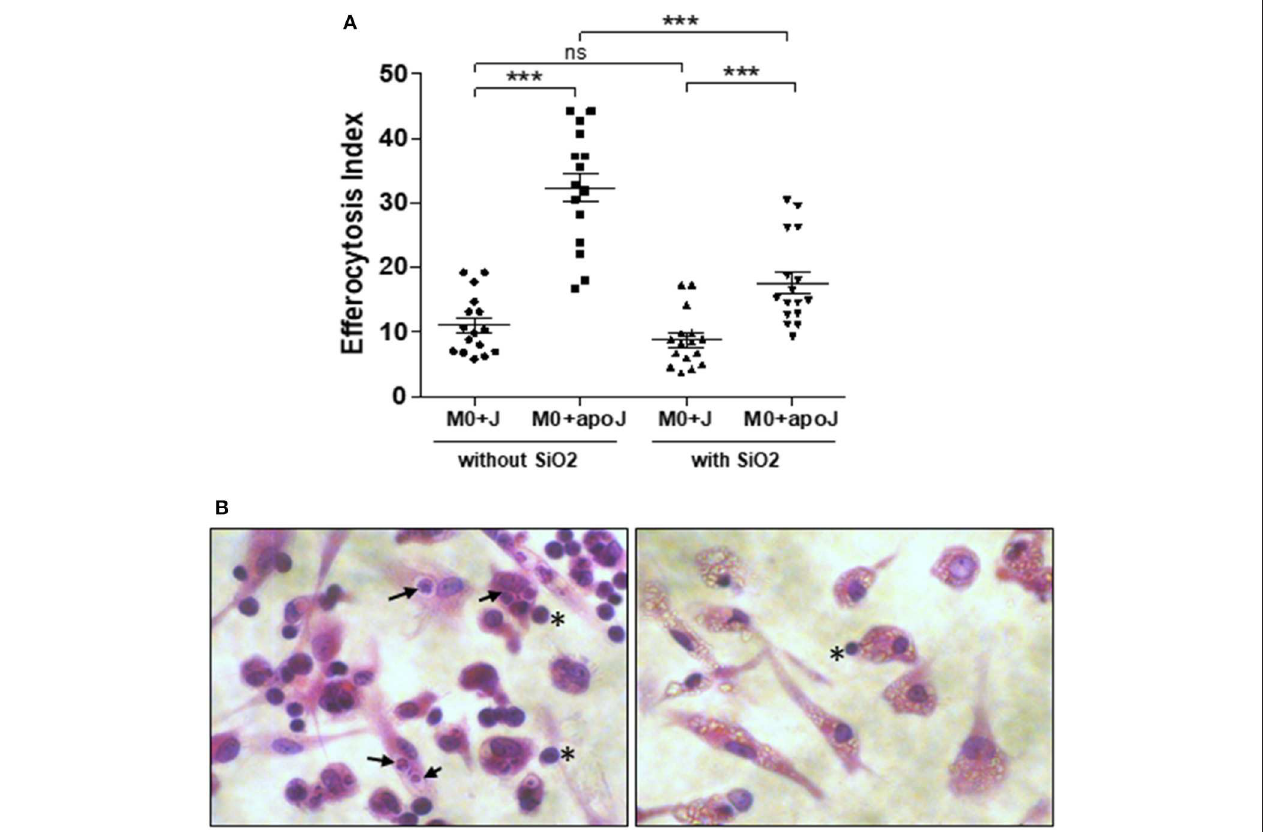
FIGURE 1 | In vitro impaired efferocytosis capacities of silica-exposed MDM. (A) EI of M0 MDM from the same healthy donors untreated or treated by 25 µ g/cm 2 of SiO 2 for 4h and then exposed to apoptotic Jurkat (apoJ) or live Jurkat (J) cells. Efferocytosis assay was performed on MDM from 16 different healthy donors. (B) Pictures of optical microscopy: M0 MDM were untreated (left) or treated with 25 µ g/cm 2 of SiO 2 for 4h (right), secondly exposed to apoptotic Jurkat cells for 90min and then stained by HES. Black arrows and stars indicate the localization of Jurkat cells inside or outside MDM, respectively. SiO 2 particles are easily visualized in MDM cytoplasm on the right picture. *** p < 0.001; ns, not significant.